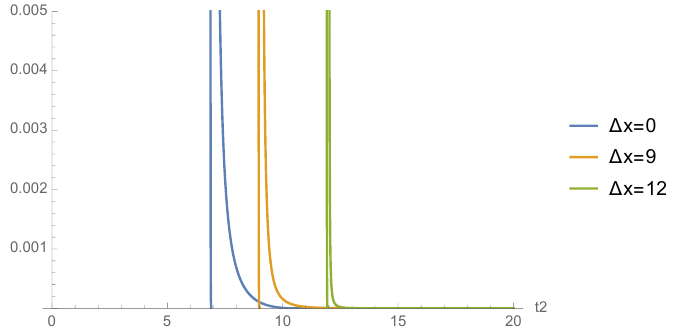
Figure 9 . This shows the profile of the commutator for t 1 = 2 T c on constant ∆ x slices as a function of t 2 . Again, the decay rate is faster for larger ∆ x , and effectively, larger t 2